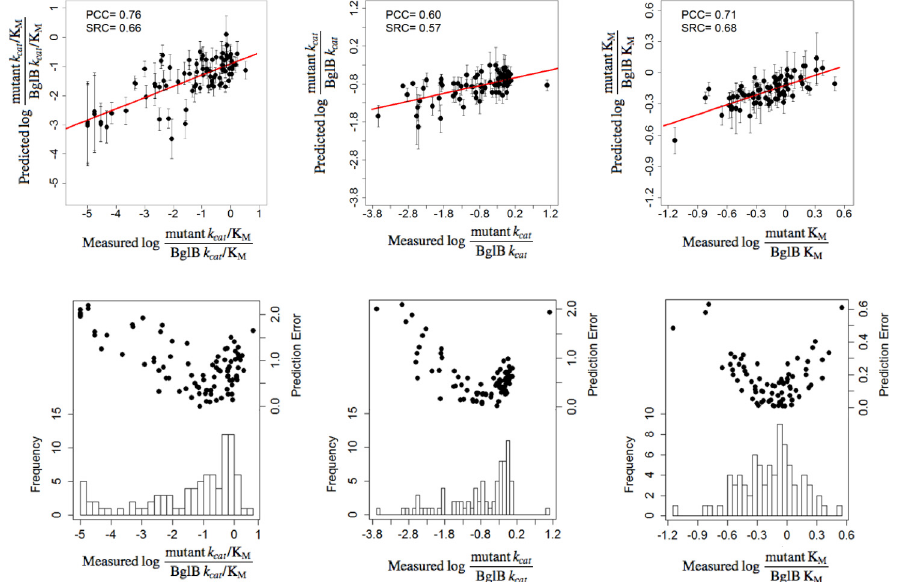
Fig 4. Correlation between machine learning predictions and experimentally-determined kinetic constants. Top panels : predicted versus experimentally-measured values for kinetic constants k cat /K M (A), k cat (B), and 1/K M (C). All values are relative to the wild type enzyme and on a log scale. The standard deviation (error bars) of the predicted values are calculated based on the prediction by 1000-fold cross validation for each point. The red line corresponds to linear regression and has been added for visualization purposes. Bottom panels : Histograms of experimentally-determined values in the data set (90, 80 and 80 samples for k cat /K M , k cat , and K M , respectively), along with the residual errors (scatter plot) between predicted and measured kinetic